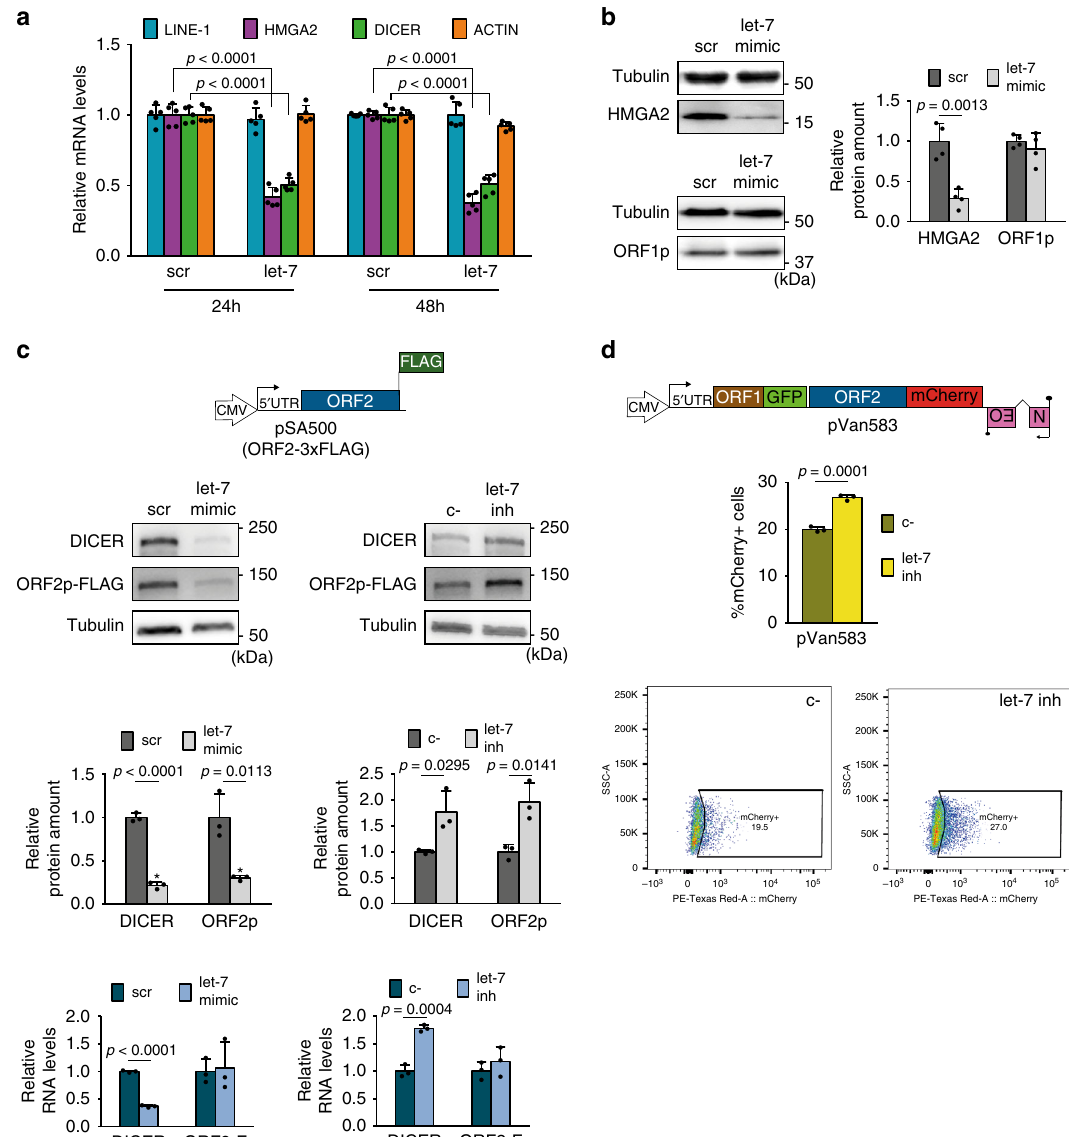
Fig. 5 Let-7 impairs L1-ORF2p translation. a RT-qPCR analysis of endogenous LINE-1 (blue bar), HMGA2 (purple bar), DICER (green bar), and ACTIN (orange bar) mRNAs upon let-7 overexpression in HEK293T. Cells were transfected with let-7 mimic or its control (scr), and RNA was extracted at 24 h or 48 h post-transfection. GAPDH was used to normalize. Data are presented as average ± s.d. of fi ve biological replicates . b Western-blot analyses of endogenous L1-ORF1p and HMGA2 protein levels in HEK293T cells upon let-7 overexpression. Cells were transfected with let-7 mimic. Representative well and quanti fi cation of the western blot are shown. Data are presented as average ± s.d. of four replicates. c Western-blot analyses of L1-ORF2p-FLAG